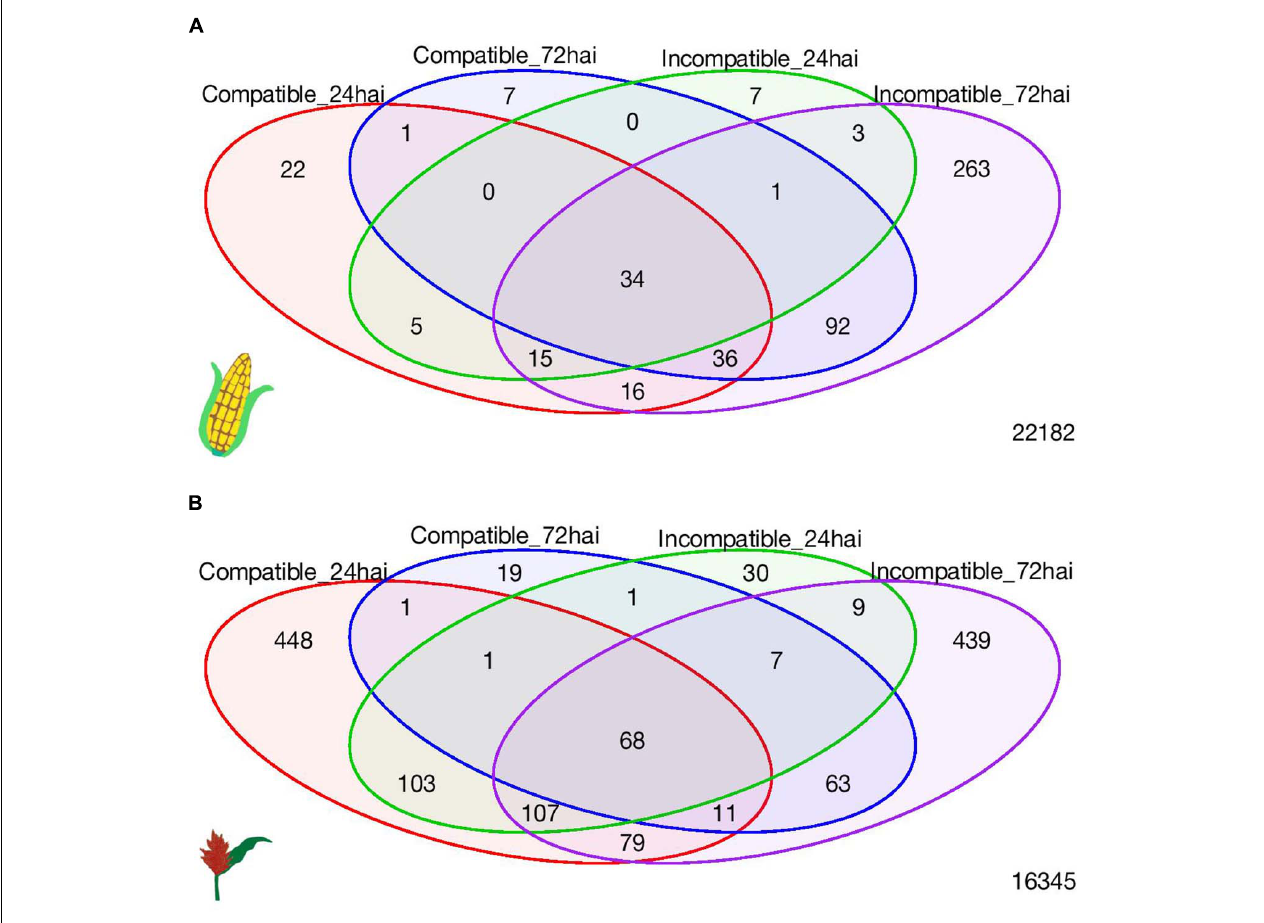
FIGURE 3 | Venn diagram of number of differentially expressed genes among four interaction-time combinations in (A) maize and (B) sorghum.